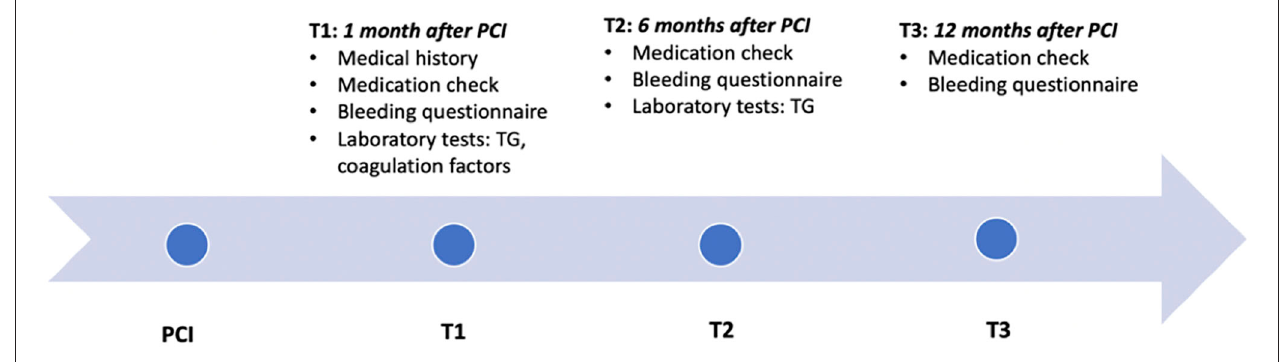
FIGURE 1 | Timeline. Timeline of the study, showing the three contact moments: TI, T2, and T3, at respectively, 1, 6, and 12 months after PCI. The collected information and performed tests at each consultation is described. TG, Thrombin generation; PCI, percutaneous coronary